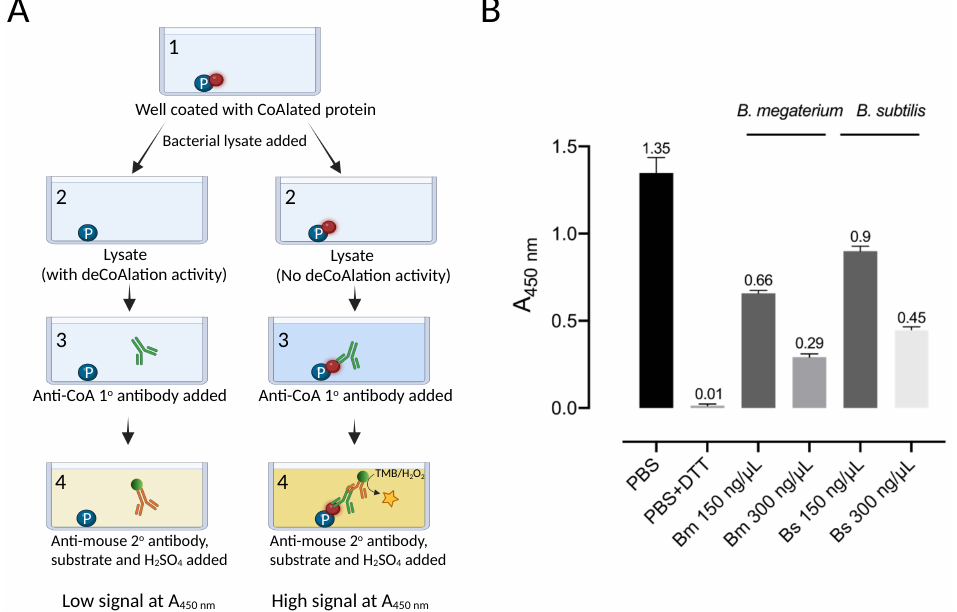
Figure 1. B. megaterium and B. subtilis lysates show deCoAlation activity. ( A ) Schematic diagram of ELISA-based deCoAlation assay. The plate is coated with CoAlated proteins (CoA–P). The protein is shown in a blue circle and CoA in a red circle. In the presence of lysates containing deCoAlation activity, CoA is released, while in lysates where deCoAlation activity is absent, CoA remains covalently bound to the protein. Then, the primary anti-CoA antibody (green) and secondary HRP-conjugated anti-mouse antibody (orange) are added. In the presence of TMB and H 2 O 2 , the color of the solution turns dark blue if CoA is still bound to the protein. H 2 SO 4 is then added to stop the reaction, and the color of the solution turns dark yellow. This results in a higher signal at A 450nm. The figure was generated by using BioRender. ( B ) The bar graph summarizes the ELISA- based deCoAlation assay using coated CoAlated-GAPDH as a substrate. In the presence of either B. megaterium or B. subtilis lysates (150 and 300 ng/ µ L), concentration-dependent deCoAlation activity is observed. As a negative control, 1X PBS or lysis buffer was added to the coated/blocked wells, which showed a high A 450nm signal. As a positive control, 10 mM DTT was added to the coated wells, where we observed loss of A 450nm signal, indicating deCoAlation of the coated CoA–GAPDH. The values above the bar graphs correspond to the average recorded A 450nm for each condition. Data from 3 independent replicate experiments are presented, and the bar graph was generated by using GraphPad Prism 8 (version